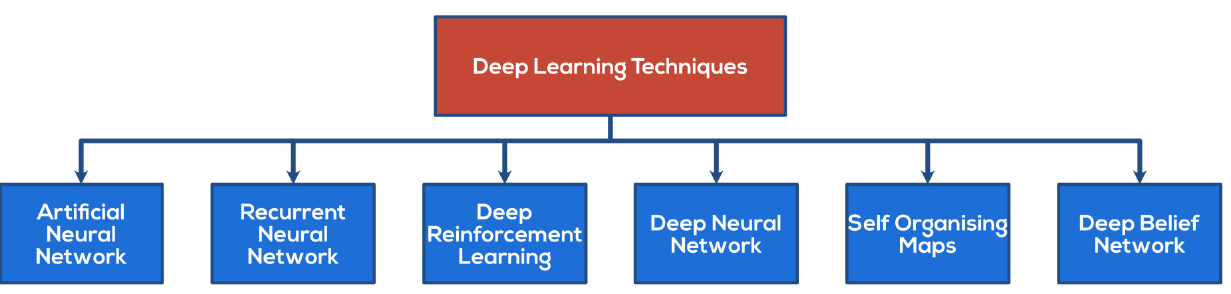
Figure 3. Current deep learning models in defensive deception—nomenclature.